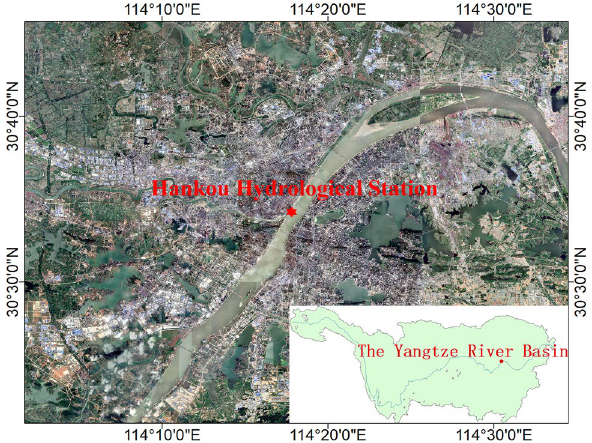
Figure 7. The location of the Yangtze River basin and Hankou Hydrological Station in